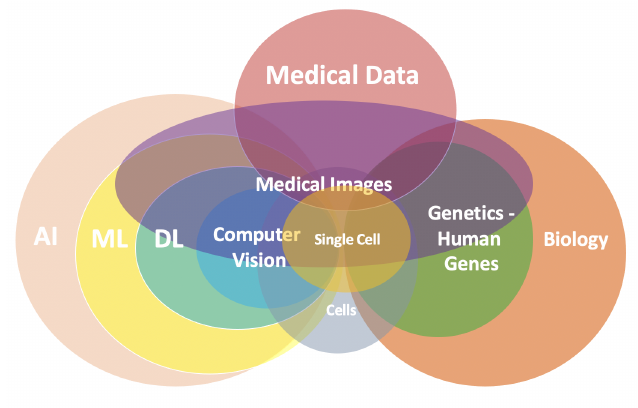
Figure 1. Scope of